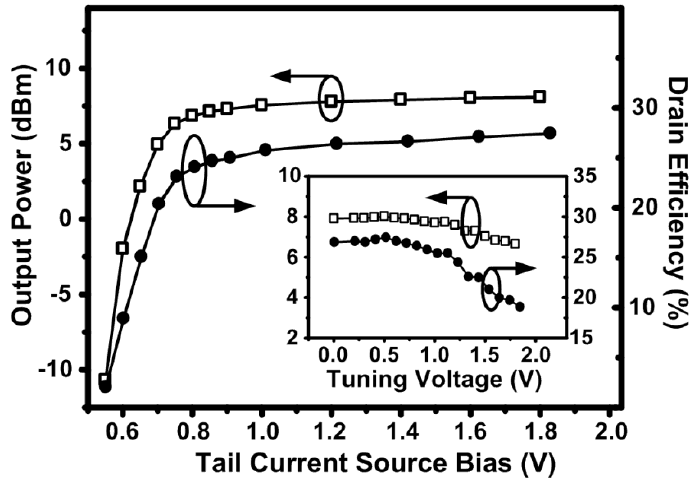
Figure 9. Measured output power and drain efficiency of the 2.4 GHz design as a function of the tail current source bias (transistor M in Figure 2) and the tuning voltage (inset figure) 5 applied to the varactors, at a supply voltage of 1.5